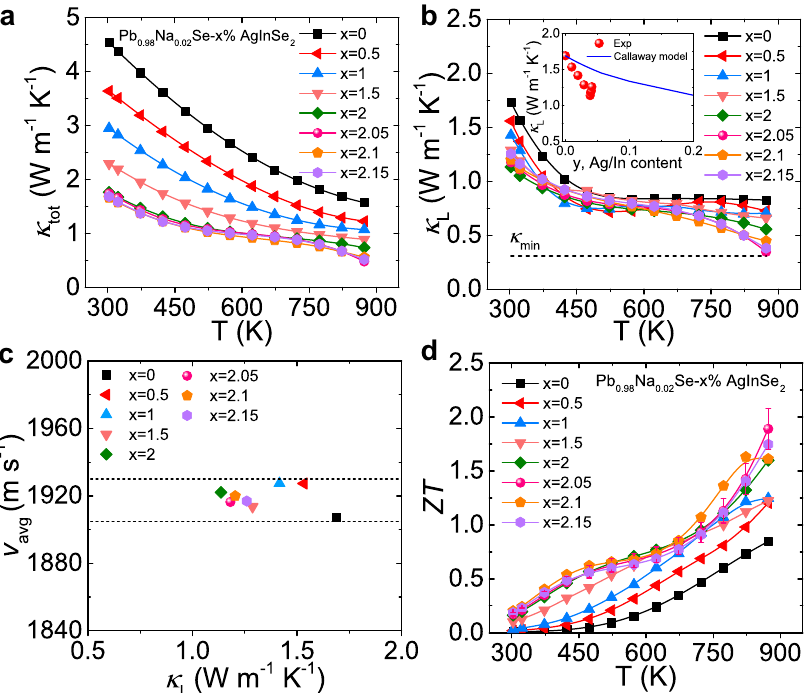
Fig. 6 Thermal transport properties and dimensionless fi gure-of-merit ZT as a function of temperature for Pb 0.98 Na 0.02 Se − x % AgInSe 2 (LISS) compounds. a Total thermal conductivity. b Lattice thermal conductivity. Inset shows the room-temperature lattice thermal conductivities departure from the theoretical line calculated by the Callaway model. c The average sound velocity ( v avg ) versus lattice thermal conductivity ( κ L ) for LISS compounds at room temperature. d Temperature-dependent ZT for LISS